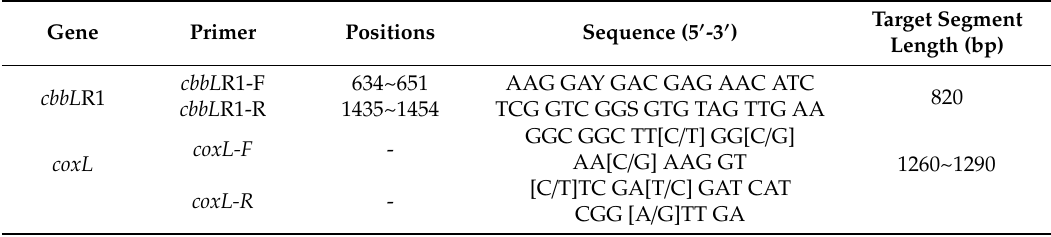
Table 1. Sequence of